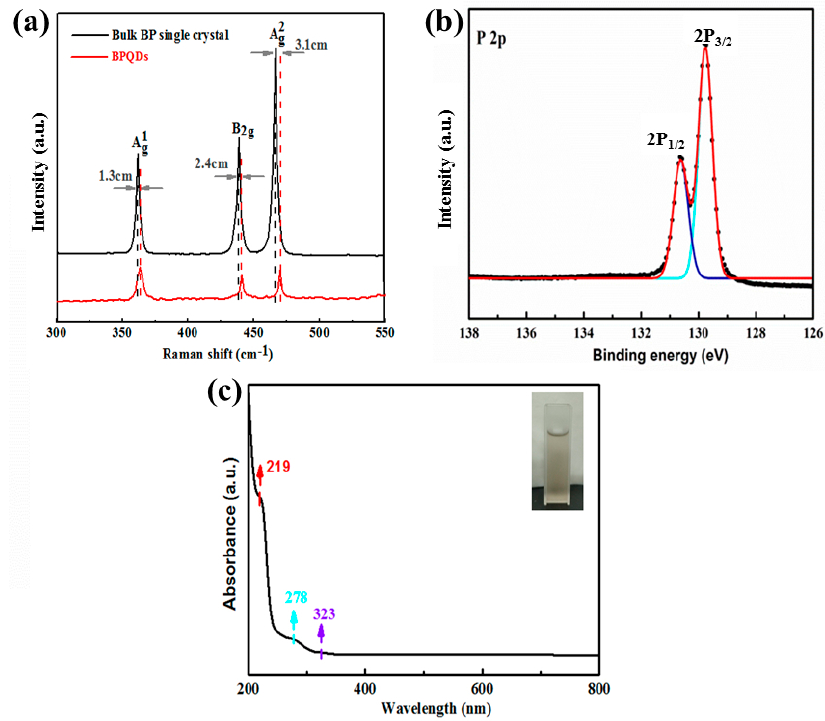
Figure 4. ( a ) Raman spectra of bulk BP and BPQDs, ( b ) high-resolution XPS spectrum of P 2p of the BPQDs, and ( c ) UV–vis–NIR absorption spectrum of the BPQDs. Inset: image of the BPQDs’ dispersion.